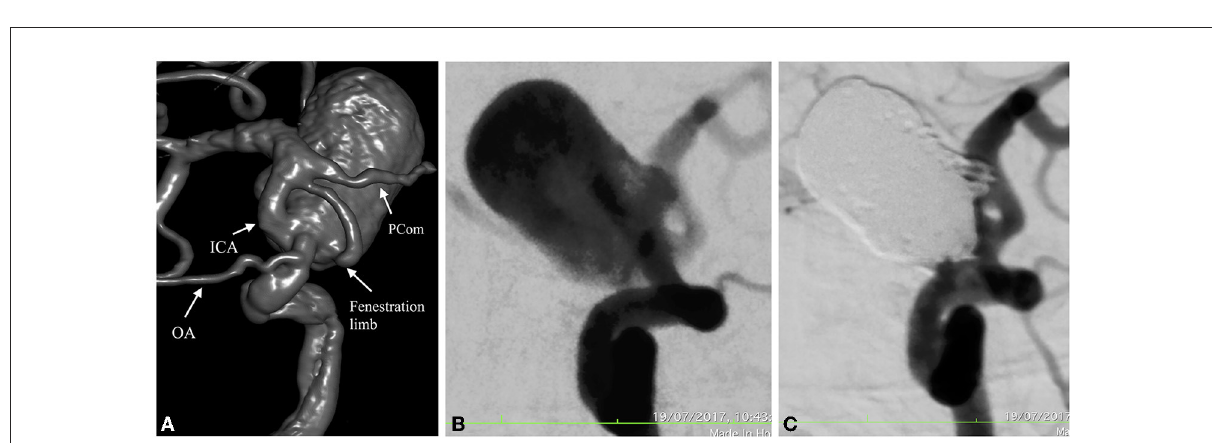
FIGURE2 3D Angio in oblique views show the fenestration arising distal to the OA and ending proximal to a fetal type PCom (A) ; DSA in working projection depicts the aneurysm before and after endovascular coil embolization with near complete obliteration of the sac (Raymond-Roy Occlusion Classification IIIb) (B,C)